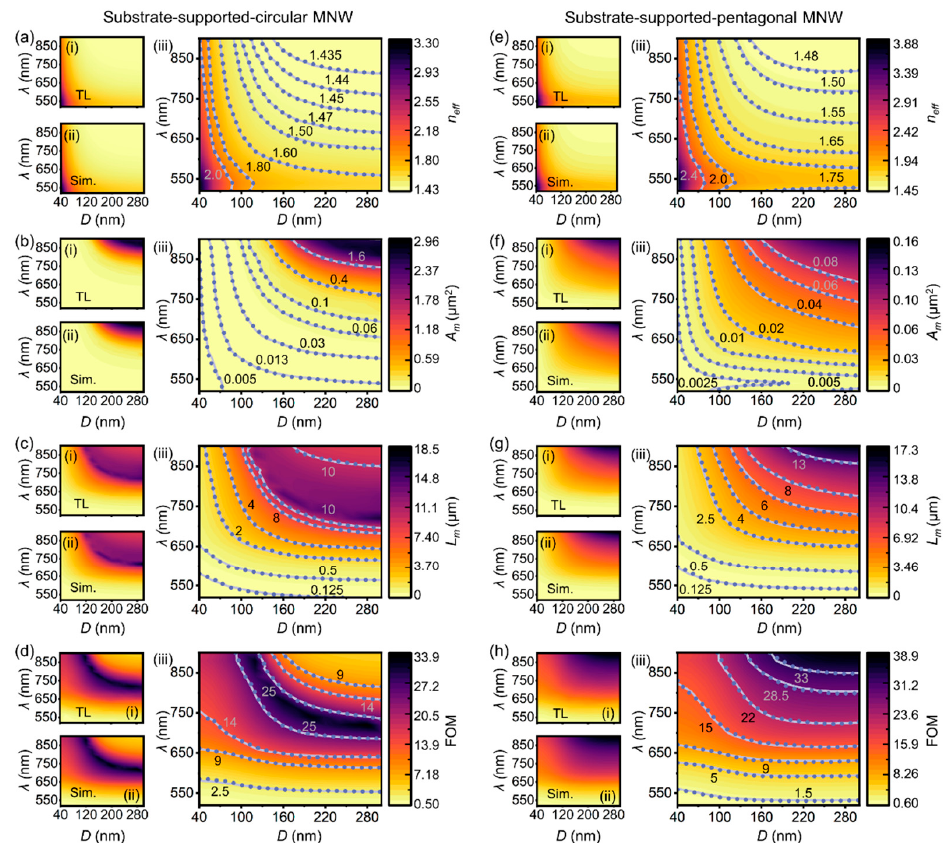
Figure 6. Accurate, effective, and comprehensive mappings of waveguiding properties of MNWs with different configurations enabled by our model. Waveguiding properties of ( a – d ) substrate- supported circular MNWs and ( e – h ) substrate-supported pentagonal MNWs over a broad range of diameters ( D ) and wavelengths ( λ ). ( a , e ) Effective index ( n eff ), ( b , f ) mode area ( A m ), ( c , g ) propagation length ( L m ), ( d , h ) figure of merit (FOM). Predictions by our model (TL, ( i ) in ( a – h )) coincide well with the numerical simulations (Sim., ( ii ) in ( a–h )), which are further verified by overlaying the images of the TL and Sim. results (( iii ) in ( a – h )). For reference, contour lines are also provided in ( iii ), where the TL (purple dotted lines) exhibit excellent agreement with the Sim. (light purple solid